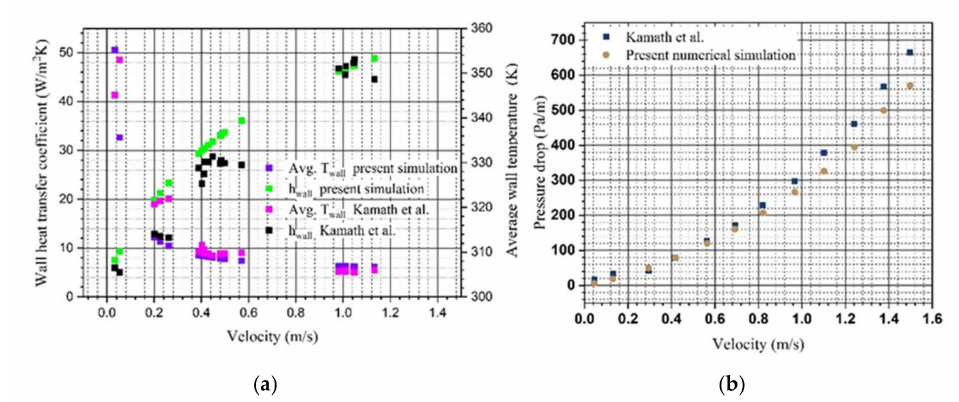
Figure 4. ( a ) Assessment of closeness of numerically predicted thermal parameters (wall heat transfer coefficient and wall temperature) for metal foam of 0.9 porosity and 20 PPI with that of experimental data. ( b ) Assessment of closeness of numerically predicted flow parameters (pressure drop) for metal foam of 0.9 porosity and 20 PPI with that of experimental